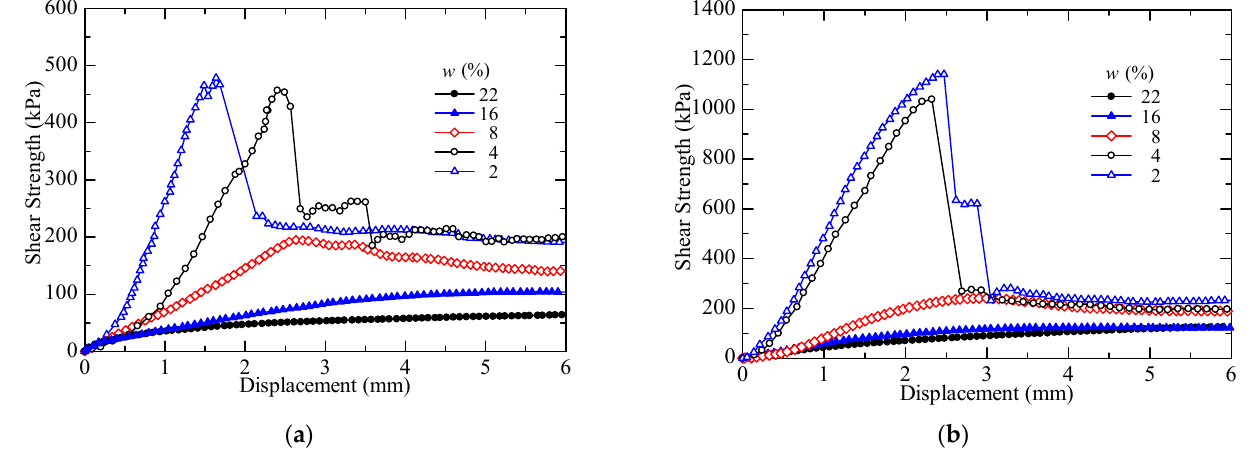
Figure 17. Wetting strength of the silt specimens with different water contents under a vertical stress of 100 kPa: ( a ) m bp / m s = 0%; ( b ) m bp / m s = 2%.